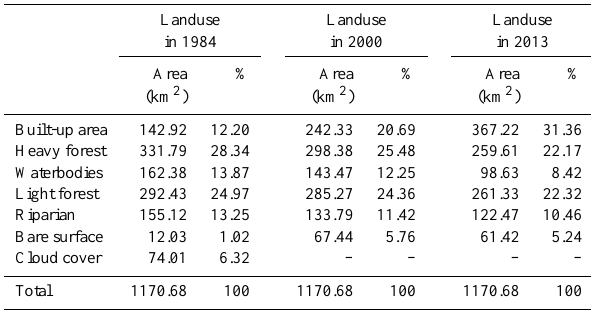
and 2013. Table 3. Landuse dynamics of Owo River Basin in 1984, 2000 and